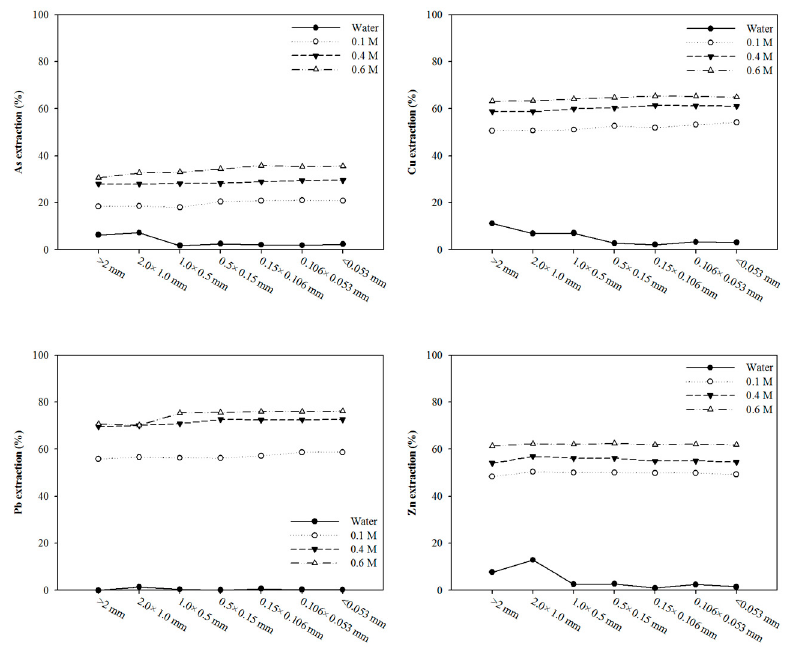
Figure 7. Effect of sulfuric acid concentrations on the extraction efficiencies of As, Cu, Pb, and Zn from the contaminated soil. The soil-washing conditions were as follows: S / L = 1:7, stirring speed: 250 rpm, and washing time: 120 min.